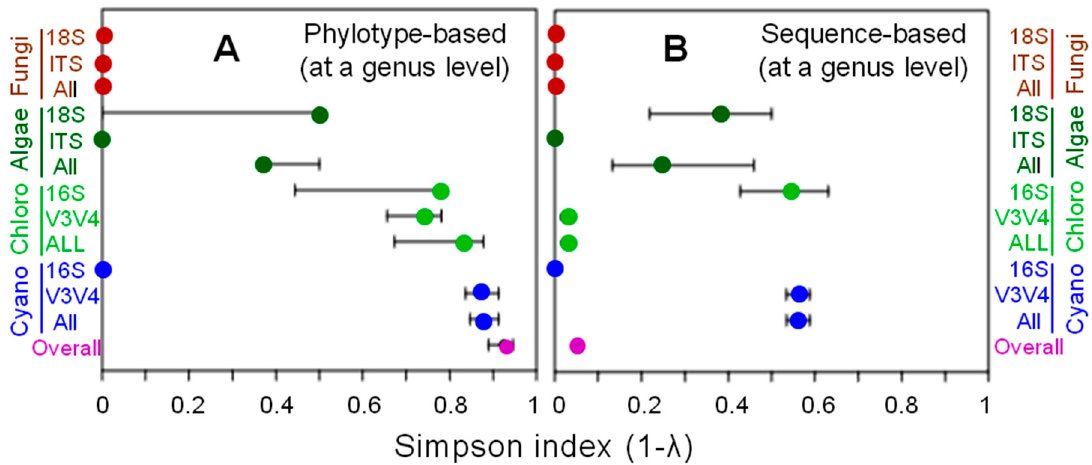
Figure 2. Simpson index (1- λ ) as a measure of diversity based on the number of phylotypes that compose a genus ( A ) as well as the number of sequences that compose a phylotype ( B ) of (from top to bottom) lichen-forming fungi, algae, algae-derived chloroplasts, cyanobacteria, and overall (Table 3). Simpson index values with error bars were calculated for: the phylotypes of fungal / algal 18S rRNA gene and ITS region; and of chloroplast / cyanobacterial 16S rRNA gene and V3-V4 region. The actual lower and upper values of the error bars as well as the actual index values are tabulated in Supplementary Table S1.